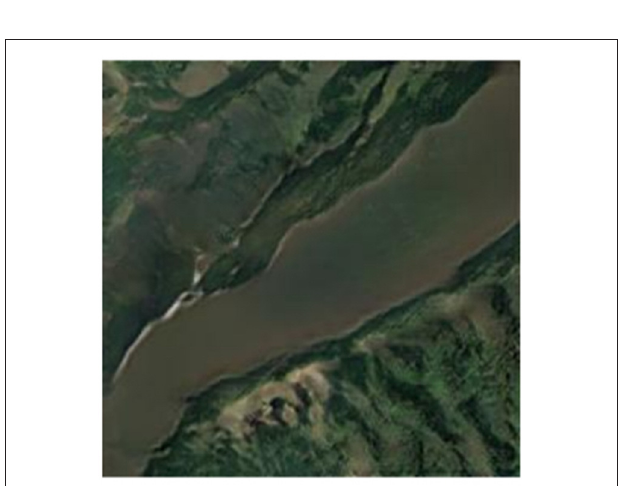
FIGURE 4 | Single GAN-generated satellite river imagery at 256 × 256